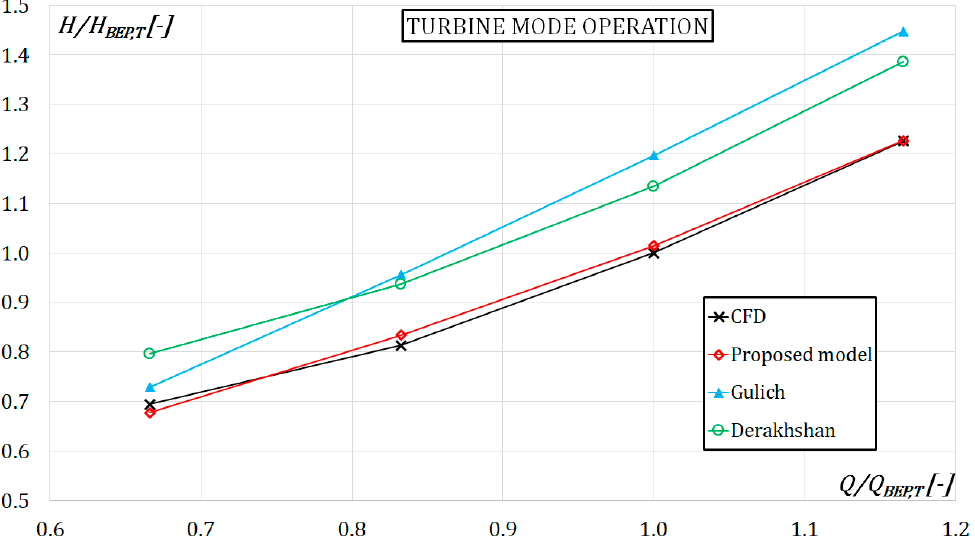
Figure 7. Comparison of different prediction models for the PaT characteristic